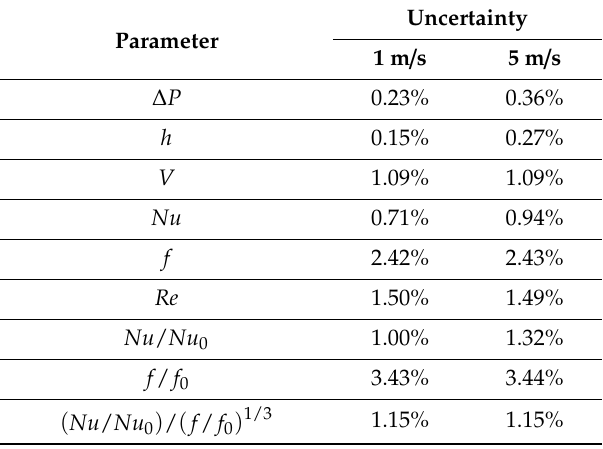
Table 2. Uncertainty of the measured value in this